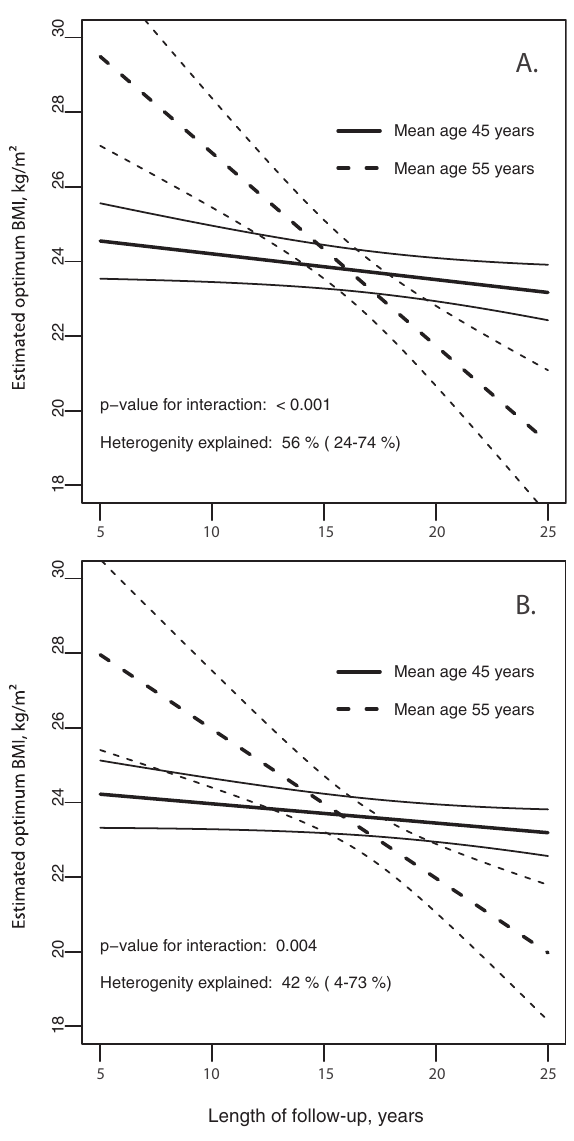
Fig. 2. Predicted optimum body mass index by length of follow-up for studies with mean age of participant of 45 or 55 years. A. all study samples, B. excluding hyper- tensive- and hyperlipidemic-only samples. BMI, body mass